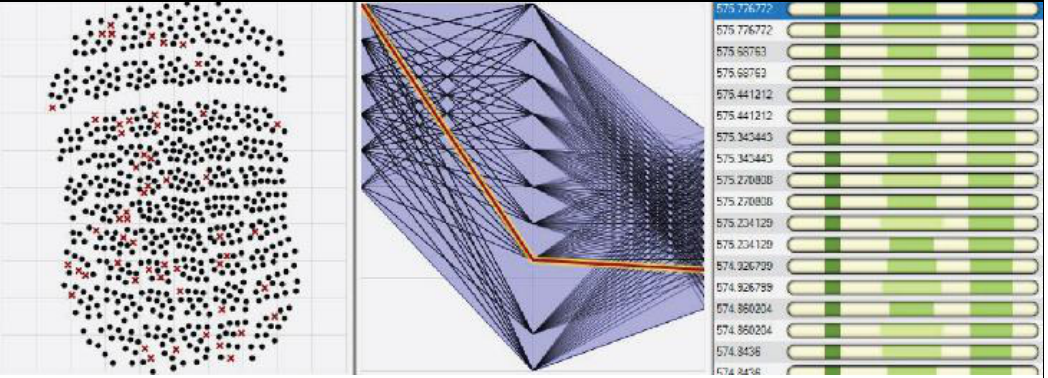
Figure 8. Visualization of the genomes and fitness in Galapagos. Control parameters were the angle and dimensions of three walls, while the fitness was determined by the cumulative solar irradiance on the three walls. In the center graphic, each polyline corresponds to a single combination.